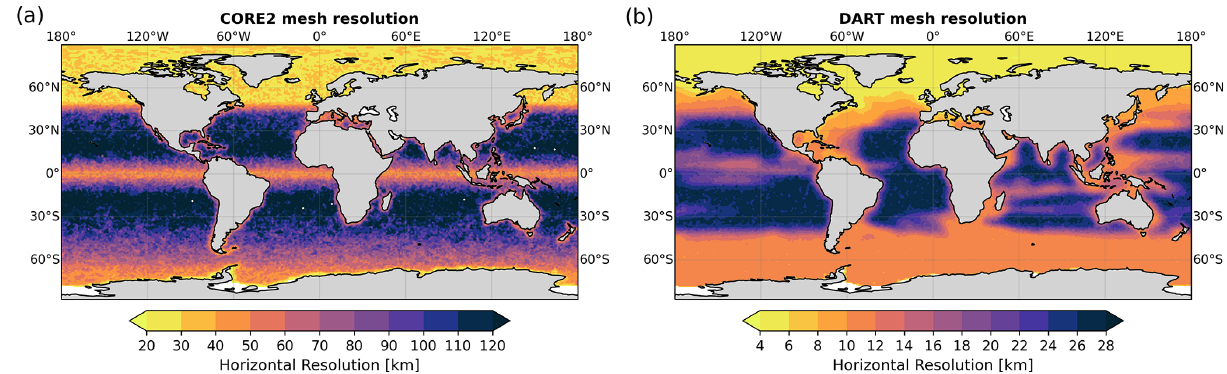
Figure 2. (a) Horizontal resolution of the CORE2 mesh used for the main simulations presented in this work. (b) As (a) but for the DART mesh with higher resolution, which is based on a mix of the local Rossby radius of deformation and local sea surface height variability. The DART mesh is used in Sect. 5.1 for an outlook on high-resolution